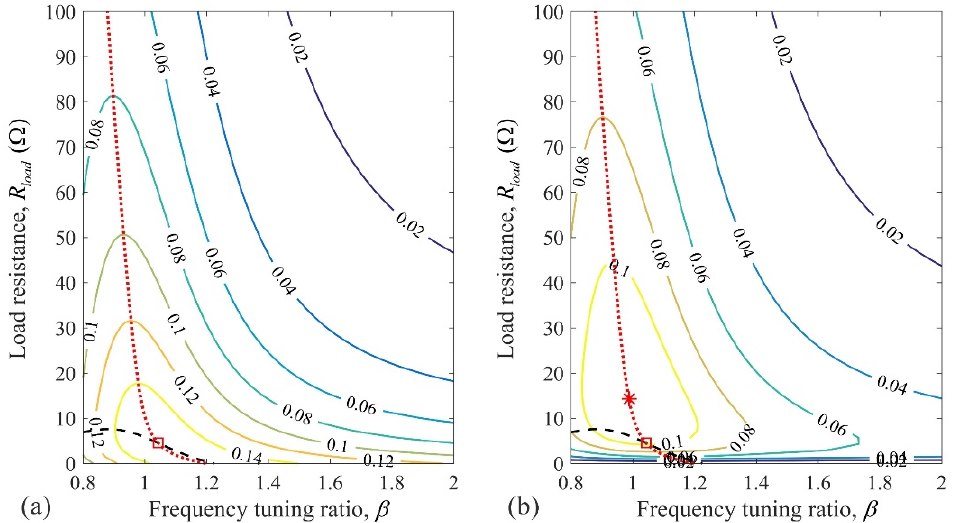
Figure 8. Contour plots of I 2 ( a ) and I 3 ( b ) superimposed with Equation (30)’s solution (black dashed line) and Equation (31)’s solution (red dotted line) when µ = 0.08 and ζ p =